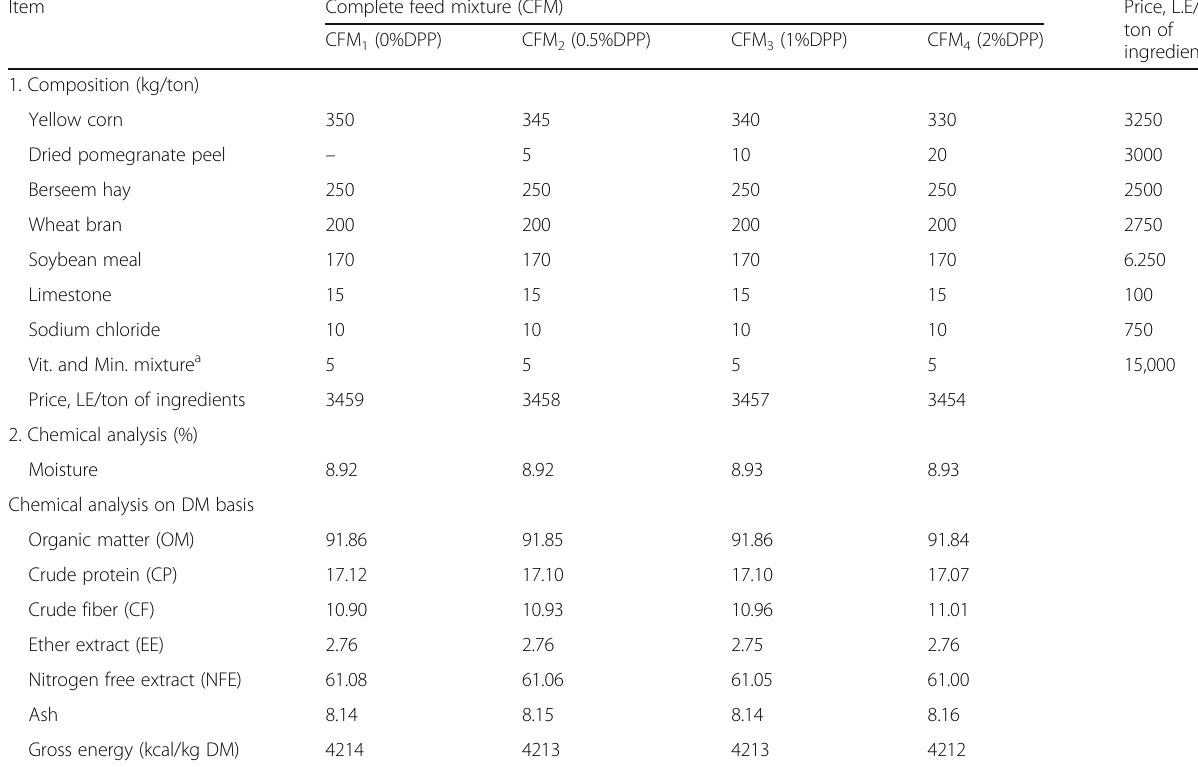
Table 7 Composition and chemical analysis of complete feed